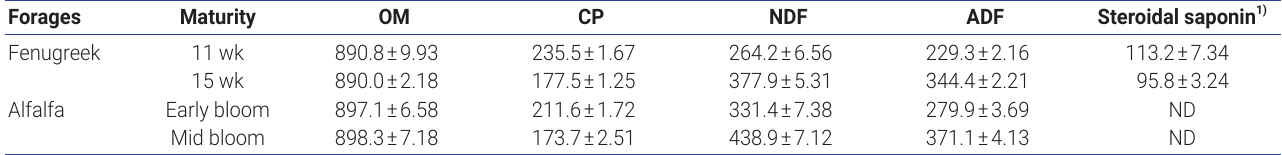
Mid bloom ND Mean±standard deviation, n = 4. OM, organic matter; CP, crude protein; NDF, neutral detergent fibre; ADF, acid detergent fibre; ND, not detected. 1) mg smilagenin equivalent/100 g.